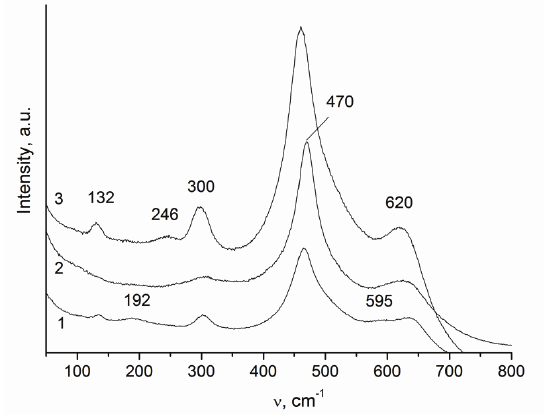
Figure 2: Raman spectra of the initial Ce-Zr supports: 1 – Ch, 2 – B2, 3 – B1.